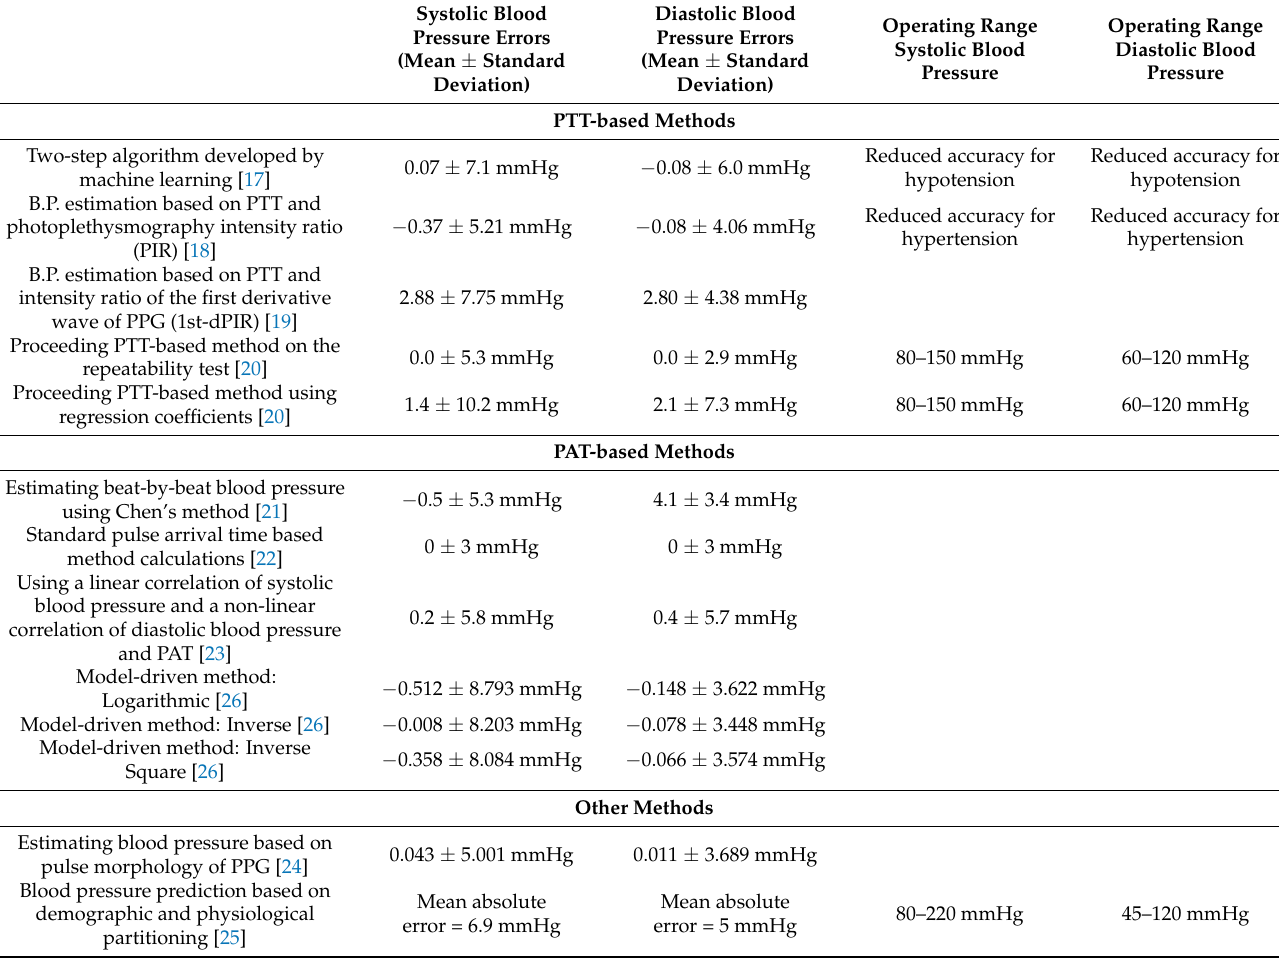
Table 1. Accuracy of previous blood pressure estimations based on PTT, PAT, and other